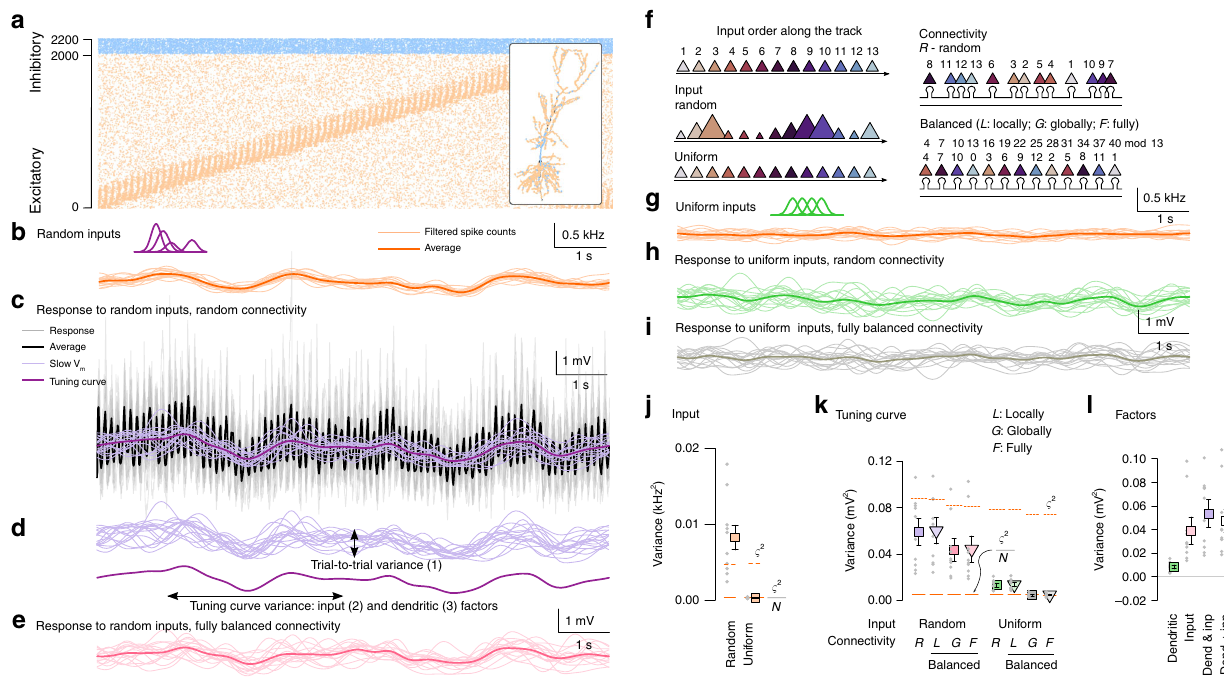
Fig. 2 Random synaptic clusters have small impact on neuronal tuning. Source data are provided as a Source Data fi le. a Activity of the 2000 excitatory (orange, ordered by the place fi eld location) and 200 inhibitory (blue) inputs in a single lap on the circular track. Inset: Morphology of the modelled CA1 pyramidal neuron and spatial distribution of excitatory and inhibitory synapses. b Filtered input spike counts in 16 individual trials (light) and average (dark) in the random input condition (purple: schematic place fi elds). c sVm response of the postsynaptic cell to inputs in 16 laps (grey), the average postsynaptic response (black), the low-pass fi ltered responses (slow V m , light purple) and the tuning curve (dark purple) in the random input condition with random connectivity. d Decomposition of the response variance: trial-to-trial variability (top) and the tuning curve variance (bottom). e Slow V m response in individual trials (light) and tuning curve (dark) in the random input condition with fully balanced connectivity. f Schematic for the inputs and connectivities. Top: ordering of 13 input place cells along the circular track. Colour difference is proportional to place fi eld distance. Left: schematic of the random and uniform inputs. The size of the symbols correspond to the total input strength at a given location. Right: schematic of random ( R ) and balanced connectivity on a short segment of a single dendritic branch. To eliminate clustering, we used a co-prime ordering procedure either locally within branches ( L ), globally ( G ) or fully ( F ; see Methods; mod is the modulo operator). g Same as b in the uniform input condition. h , i Same as e with uniform inputs and random ( h ) or fully balanced ( i ) connectivity. j Variance of the average fi ltered input spike count in random and uniform input conditions. Solid line segments show the lower bound of the variance of the average of 16 laps based on trial-to-trial variability ( ς 2 ∕ N ) and dashed segments indicate trial-to-trial variance. k Tuning curve variance in the random and uniform input conditions with either random ( R ) or locally ( L ), globally ( G ) or fully balanced ( F ) connectivity. l Contribution of dendritic and input factors to response variance. Grey dots in j – l show N = 10 independent simulations with different synaptic con fi guration and inputs. Symbols and error bars show mean and